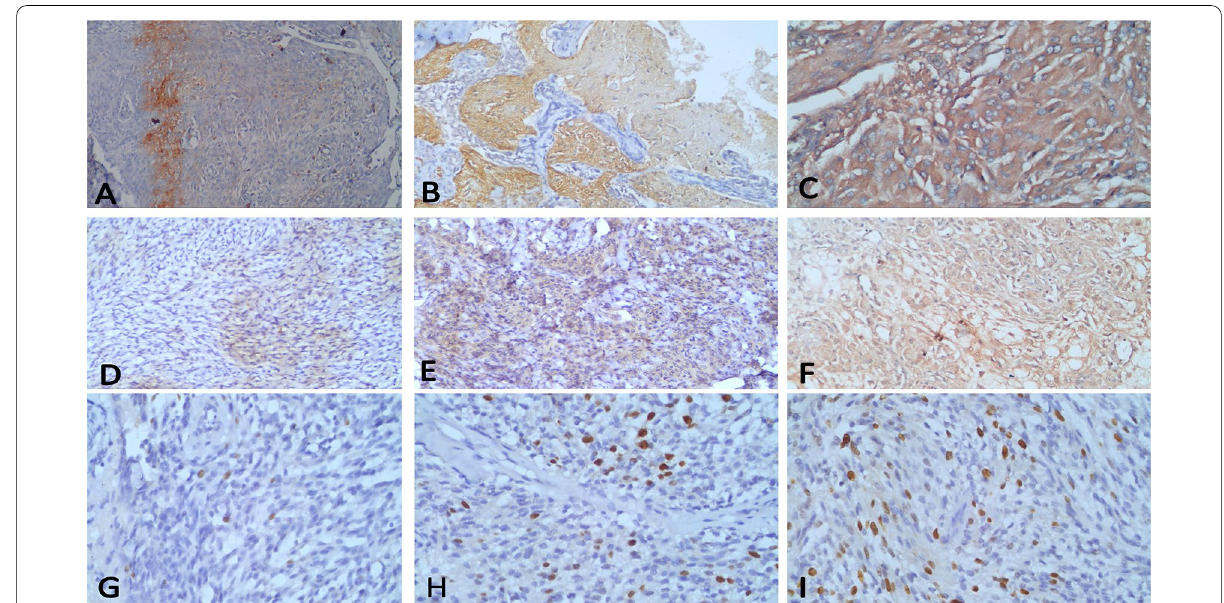
Fig. 1 Immunohistochemistry finding for CD44, MMP9 and Ki67 in meningiomas. CD44 expression A – C demonstrated low score in GI meningioma ( A ) and high score in brain invasive meningioma ( B ) and anaplastic meningioma GIII ( C ) (original magnification A and Bx200 Cx400). MMP9 expression in meningiomas D – F showed the highest score in anaplastic meningioma ( F ), (original magnification A and Bx200 Cx400). Ki67 expression in meningiomas ( G – I ) demonstrated high Ki-67 LI in both atypical and anaplastic meningioma (original magnification